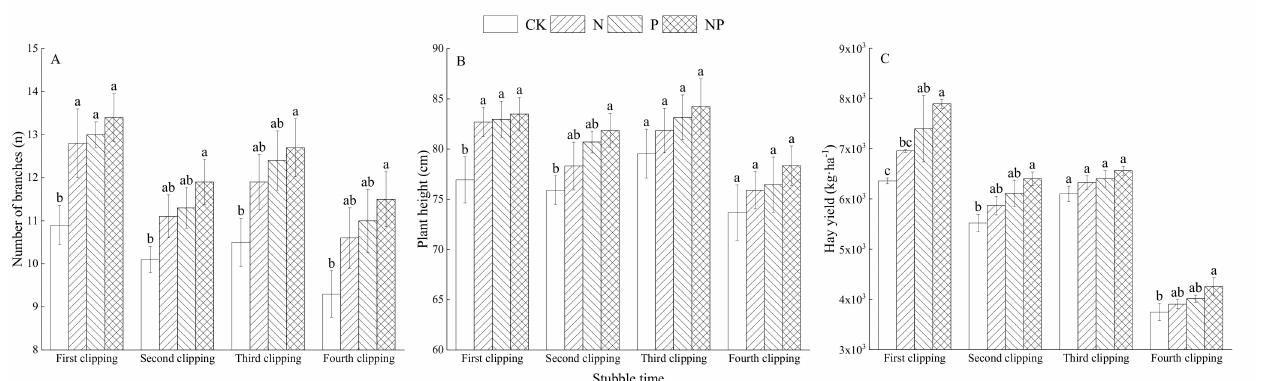
Figure 1. Effect of nitrogen and phosphorus on agronomic parameters and hay yield of ( A ) the num-ber of branches, ( B ) plant height and ( C ) hay yield of alfalfa. Different letters above column indicate significant difference among treatments with different ( p <